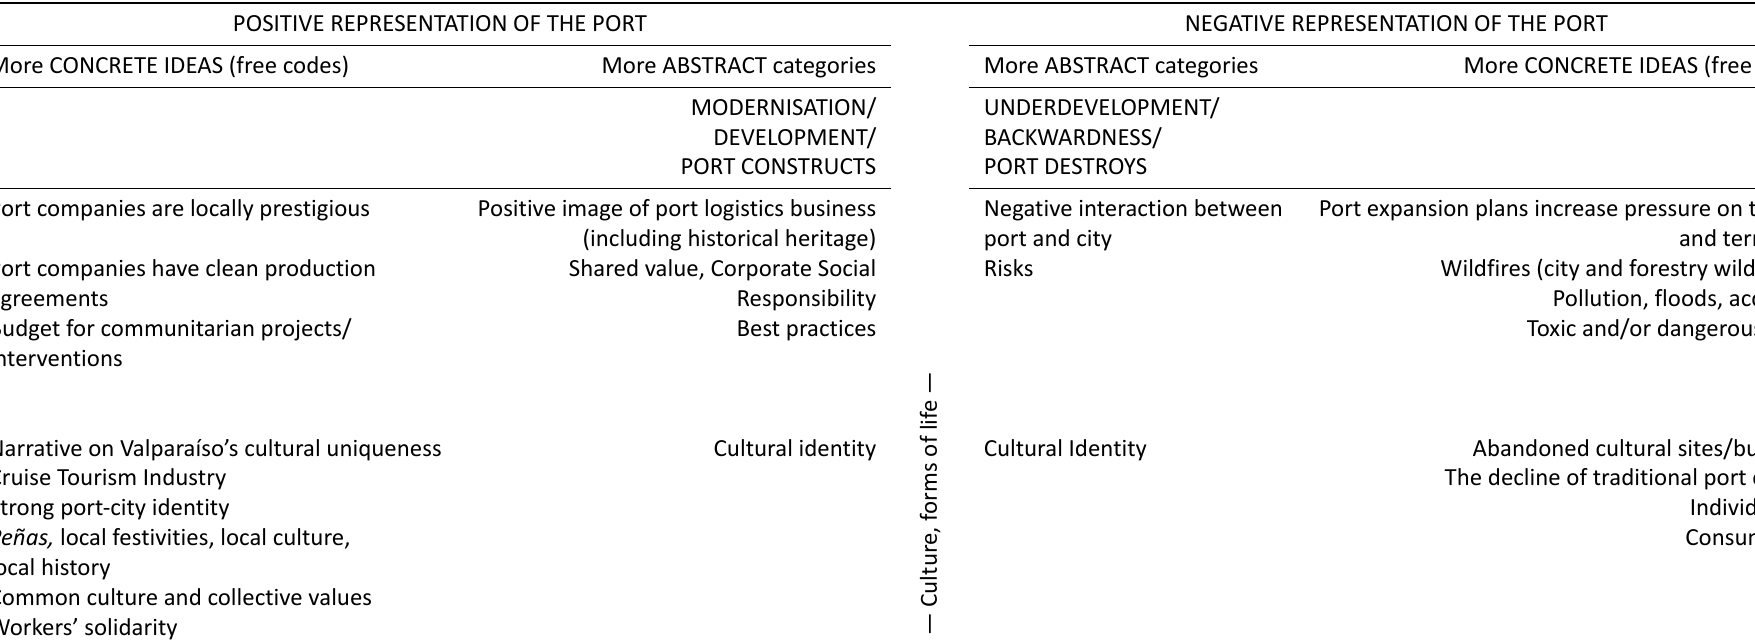
Table 1. (Cont.) Cultural representations of the port‐city